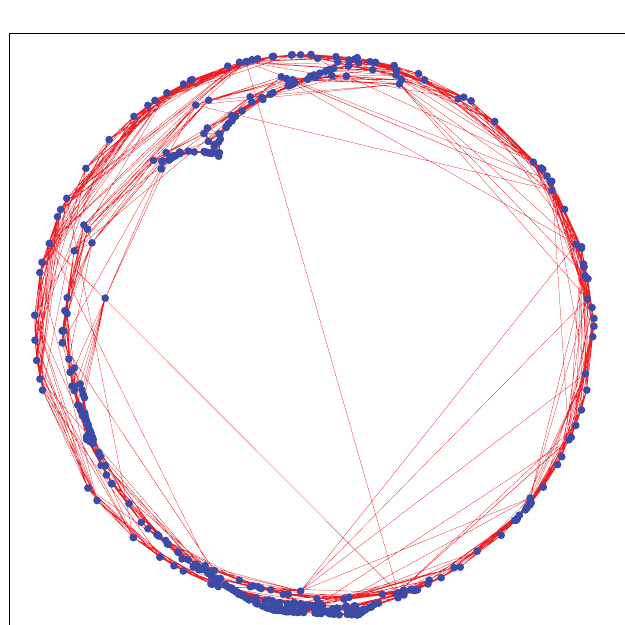
same direction. System size increases from right to left. (C) Extrapolation of η c ( N ) values determined from (A) and (B) . We obtained η c ( N ) = 1 . 70 + N − 1 / 2 . 86 and η c ( N ) = 1 . 82 + N − 1 / 3 . 50 , respectively.